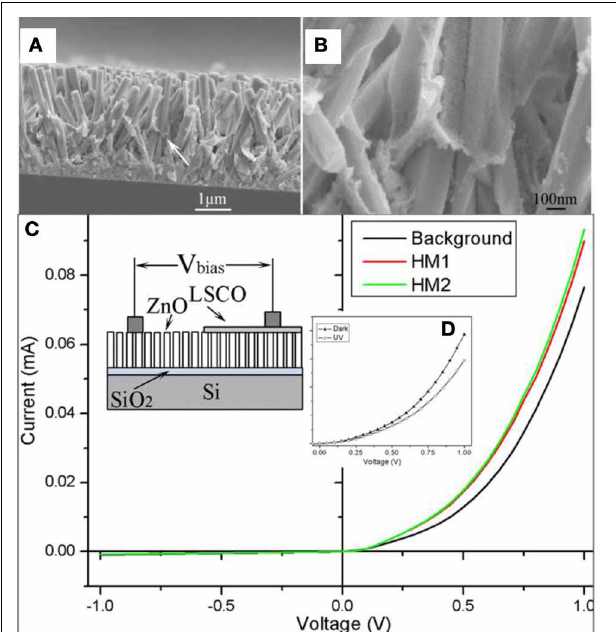
FIGURE 8 | Humiditysensorconfigurationandpropertybasedon ZnO/LSCOhierarchicalcompositenanowiresarraypreparedbya combinationofhydrothermalandcolloidaldepositionmethod.(A,B) CrosssectionviewofZnO/LSCOcore-shellnanowiresarraybySEM. (C,D) MagnifiedSEMimagesofZnO/LSCOcore-shellnanowiresarray.[Reprinted withpermissionofreferenceGaoetal.(2010).Copyright2010IOPScience].